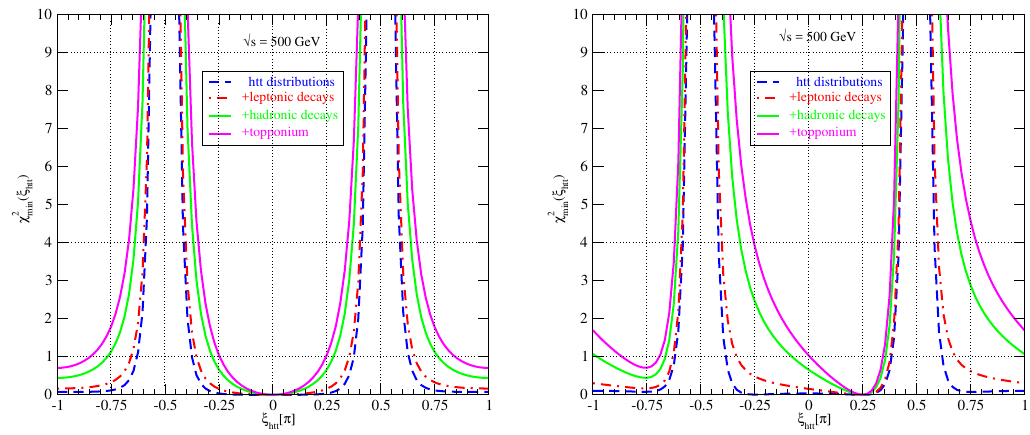
Figure 10 . The (cid:31) 2 plot at p s = 500 GeV. (cid:24) ex